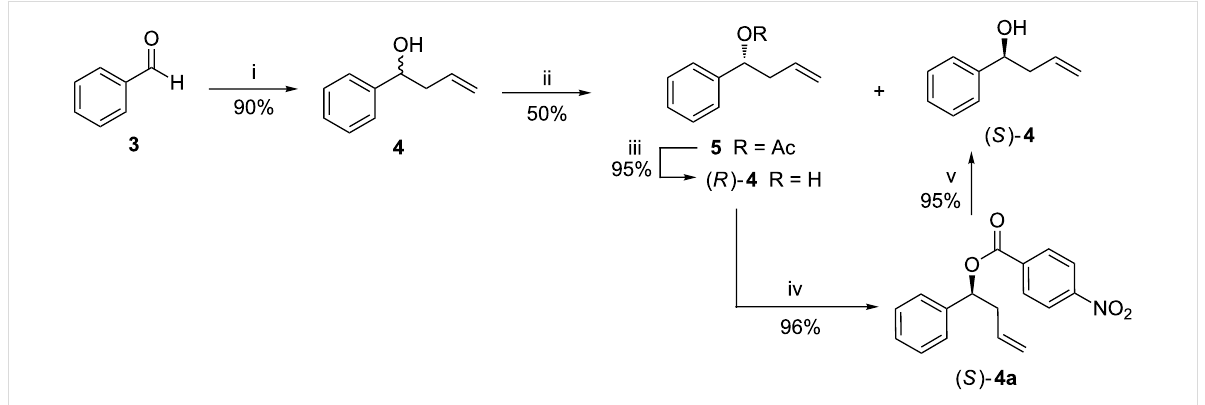
Scheme 1: Lipase-catalyzed trans-acylation of (±)- 4 and subsequent Mitsunobu inversion. Conditions: (i) Zn/THF/allyl bromide/aqueous sat. NH 4 Cl/ 25 °C/3 h; (ii) vinyl acetate/lipase (Table 1); (iii) KOH/EtOH/25 °C/6 h; (iv) Ph 3 P/DIAD/ p -nitrobenzoic acid/THF; (v) KOH/EtOH/25 °C/8 h.